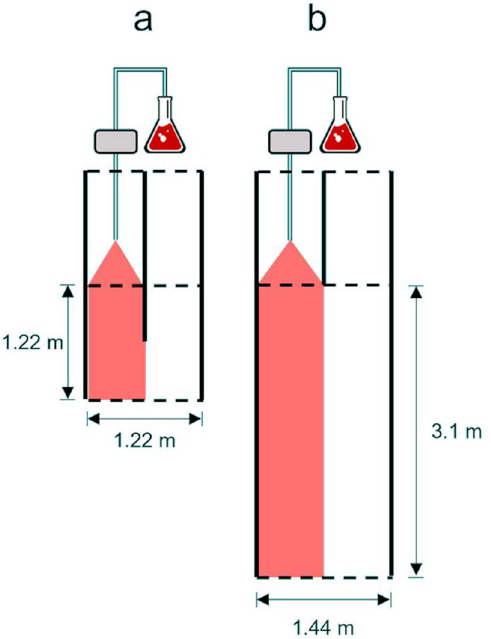
Figure 1. Schematic of experimental arenas: ( a ) small individual animal assay and ( b ) larger multi-animal assay, drawn to scale. Fish were introduced into the center of the area at the beginning of trials and were able to move freely throughout the arena over the course of the trial. Odor was introduced through one peristaltic pump before the stimulus observation period, and pump sides were switched after the completion of each trial. Dotted lines represent blocknets and thick black lines represent impervious and impassable